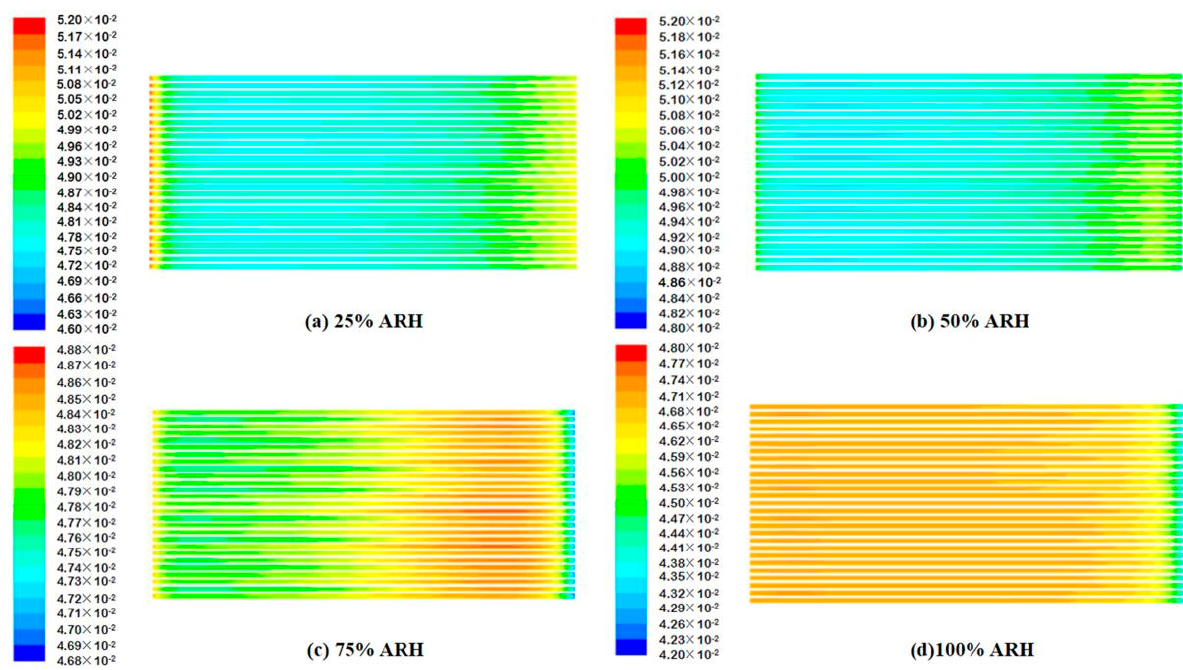
Figure 7. Contours of hydrogen molar concentrations (kmol·m − 3 ).